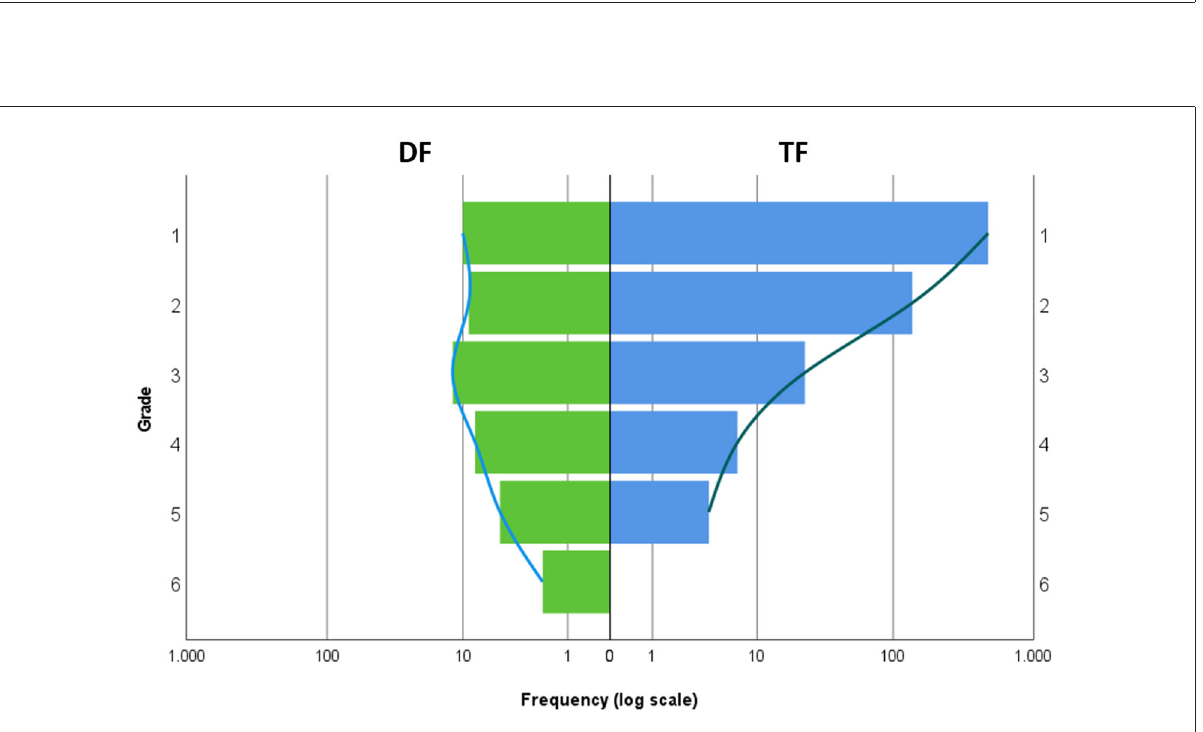
FIGURE2 Comparison of DF and TF with respect to the frequency of school grades. Left/green: DF, right/blue: TF. The x axis shows the frequency of each grade displayed on the y axis. To account for the different sample sizes of DF and TF, a logarithmic scale was used for the x